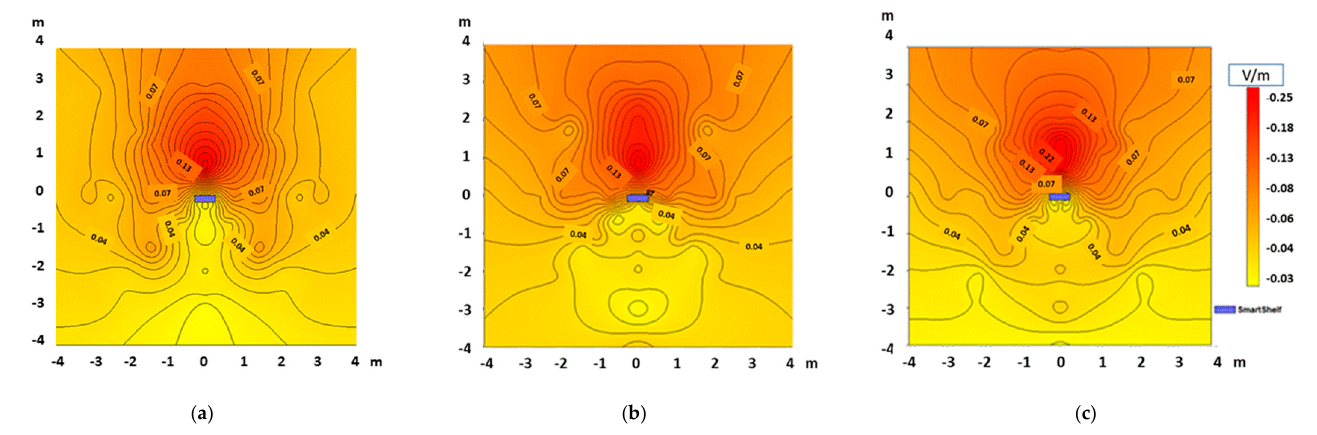
Figure 14. 2D Contour map of the experimental values of the E-field (V/m) in the vicinity, up to 4.0 m from the center point, of AS-RFID reader: ( a ) at 1.0 m height above the floor; ( b ) 1.3 m height above the floor; ( c ) 1.7 m height above the